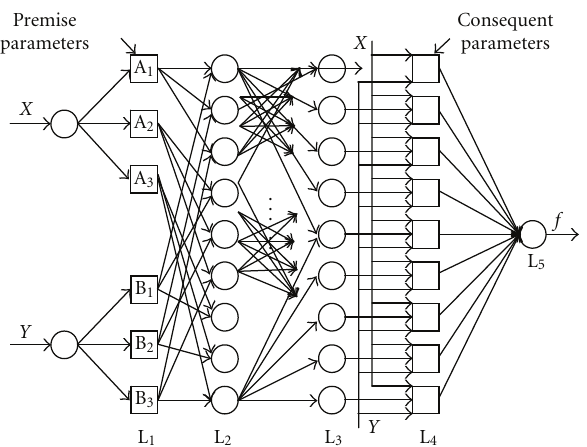
Figure 1: Architecture of artificial neural network system.